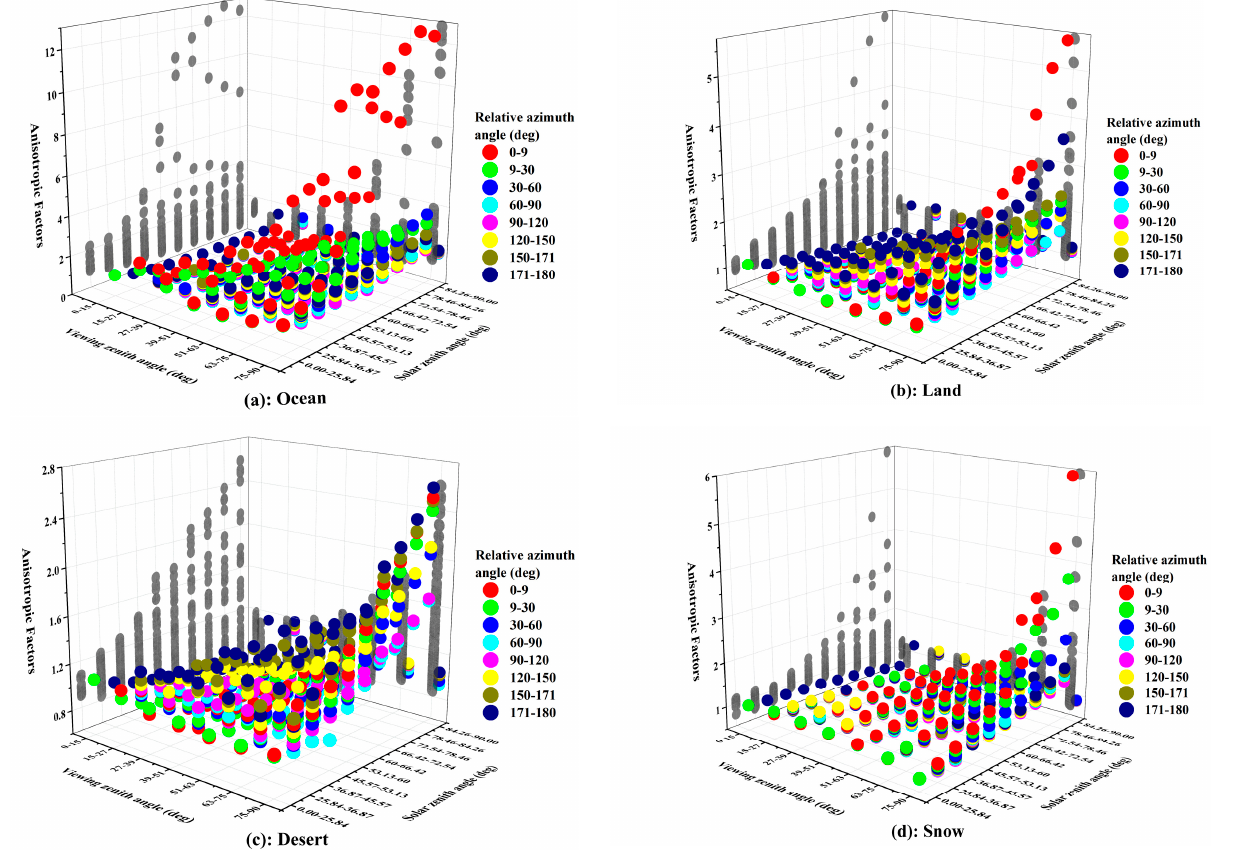
Figure 6. Anisotropic factors of different scene types and incidence-viewing geometry. Grey dots are the projections on the X-Z plane and Y-Z plane,